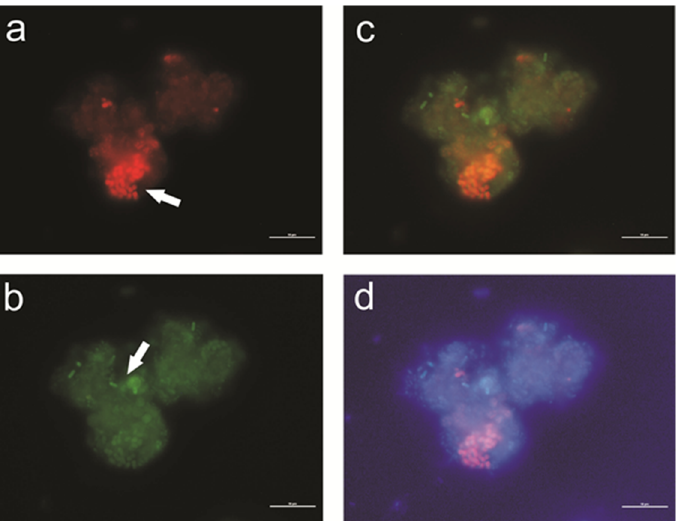
Figure 7. FISH hybridization of bacteria from the IFAS reactor. Candidatus Accumulibacter phosphatis identified with the PAO462 probe ( a ) and Candidatus Competibacter phosphatis identified with the GAOQ431 probe ( b ) in activated sludge. The effect of overlaying images a+b ( c ), a+b+c ( d ), and a+b+DAPI ( d ). Scale bar: 10 μ m.